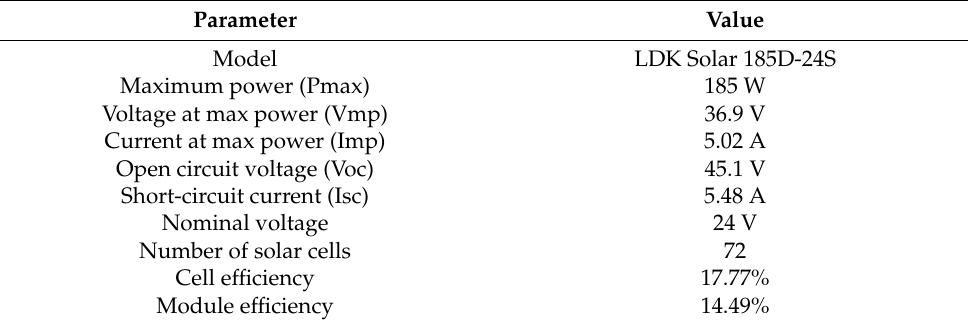
Figure 8. PV generator for experimentation. Table 3. Main parameters of PV